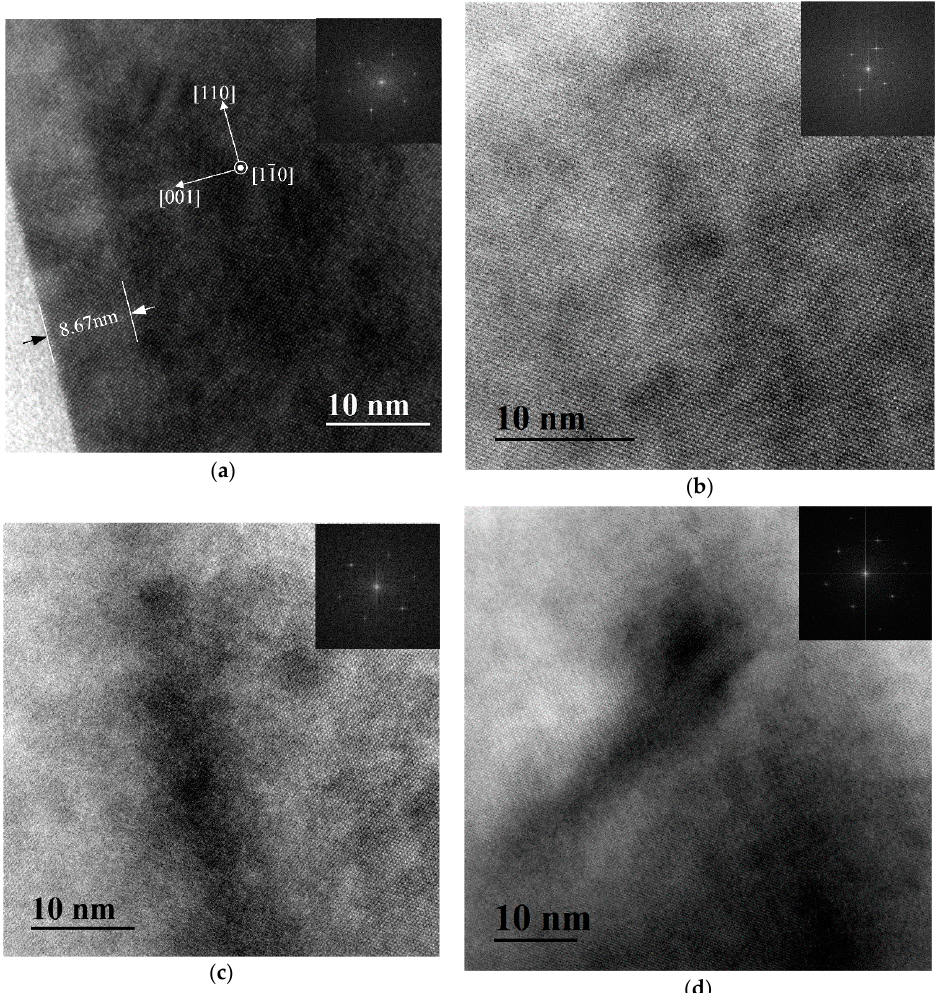
Figure 7. High-resolution transmission-electron microscopy (TEM) images of sample cross-section ( a ) at the ε -Si and Ge 0.2 Si 0.8 layers, ( b ) inside the Ge 0.2 Si 0.8 layer, ( c ) at the Ge 0.2 Si 0.8 /Ge x Si 1 − x interface and ( d ) inside the Ge x Si 1 − x layer.